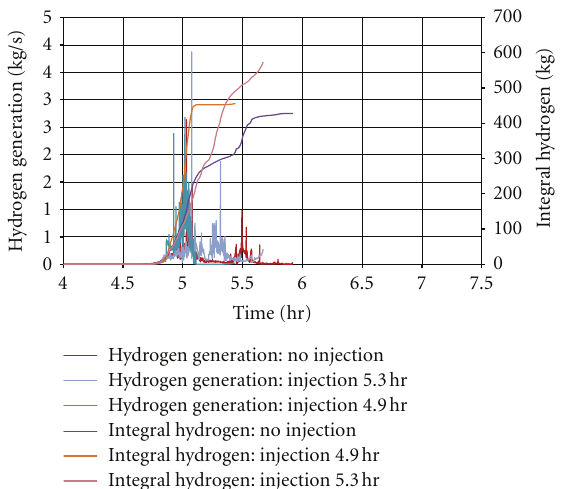
Figure 24: Hydrogen generation rate and integral hydrogen for scenarios with and without water injection after the start of core uncovery (all emergency water injection was terminated at 4.2 hours after reactor